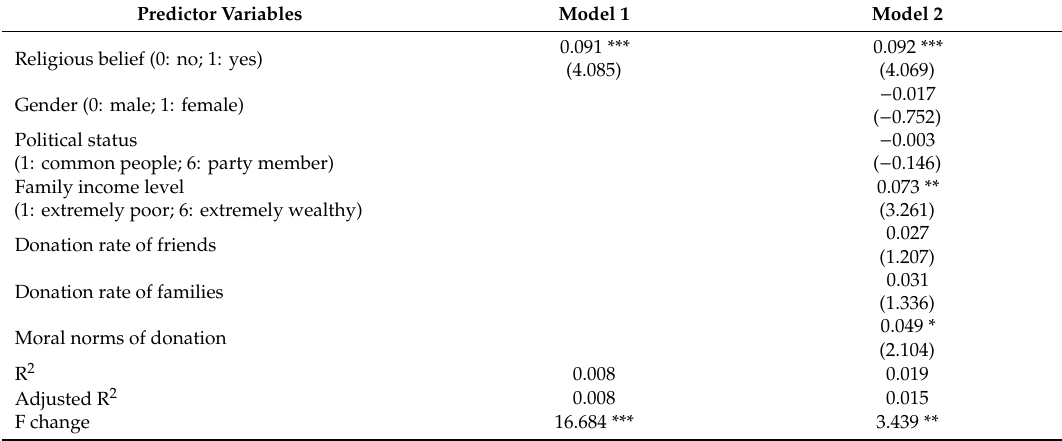
Table 2. Hierarchical regression results for the average amount donated each year (N =